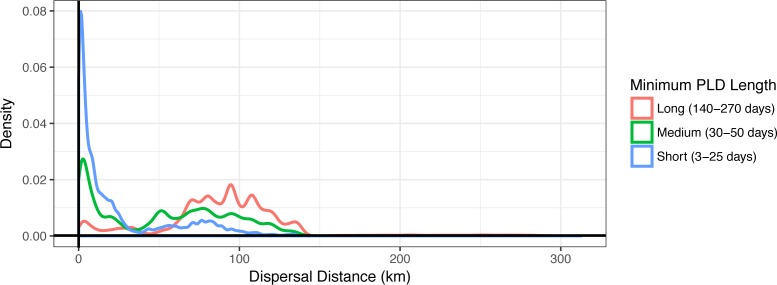
Dispersal distance density kernels.Dispersal distance is combined across species by minimum pelagic larval duration (PLD) length in days (short, medium, or long). Most short dispersers settle close to home, while few long dispersers are retained at or near their spawning sites.